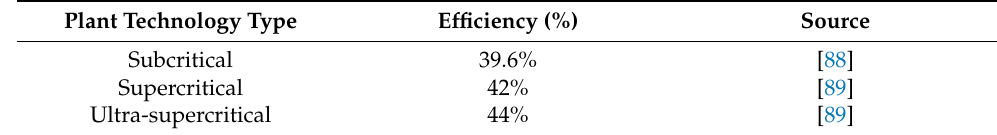
Table A8. Plant efficiency assumptions by technology